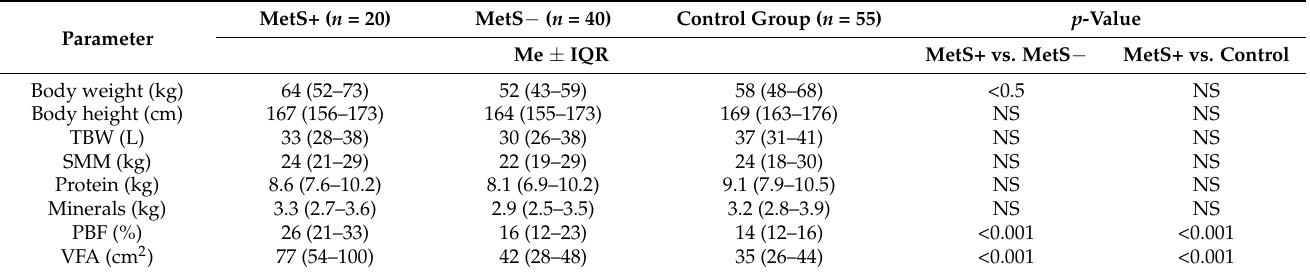
Table 6. Comparison of body-composition analysis parameters.